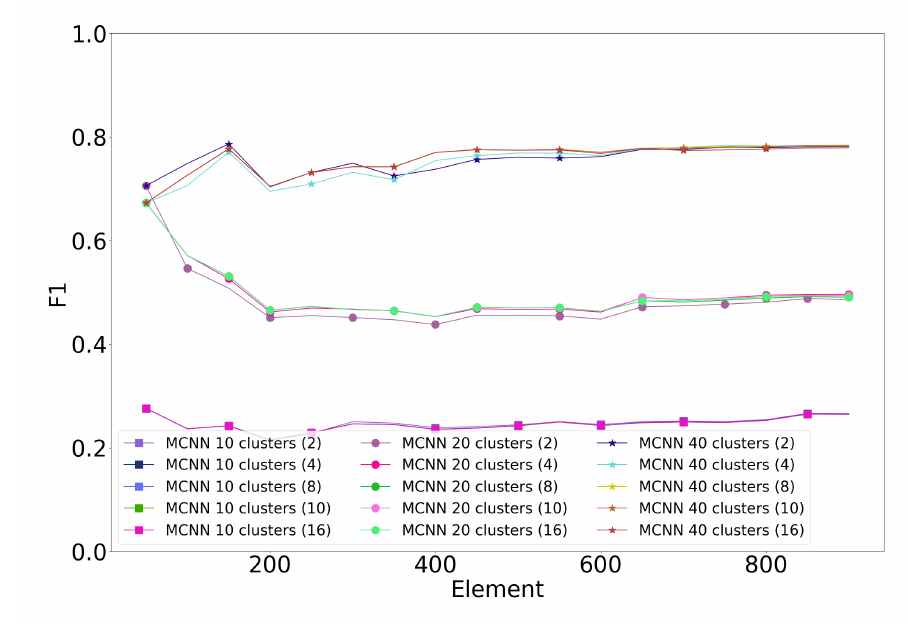
Figure 4. Error threshold tuning of MCNN with the first subject of Banos et al. dataset. Error threshold in